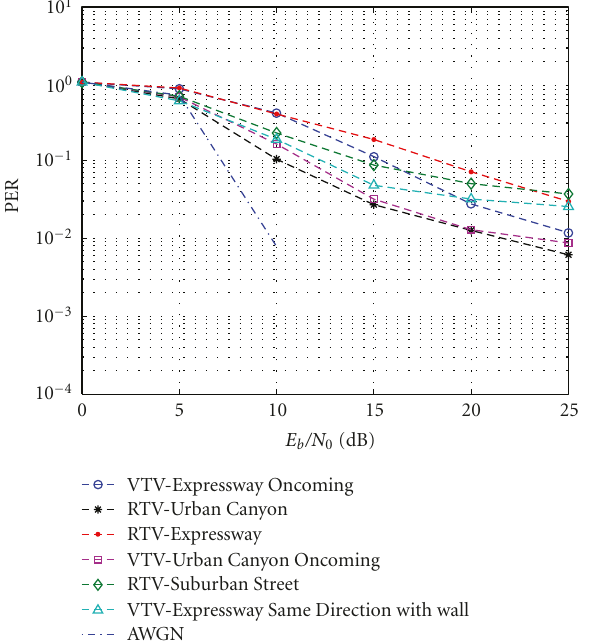
Figure 11: PER of the transceiver for the di ff erent vehicular channels. Table 6: Minimum E b /N 0 to obtain a PER of 10%. Vehicular Channel VTV-Expressway Oncoming